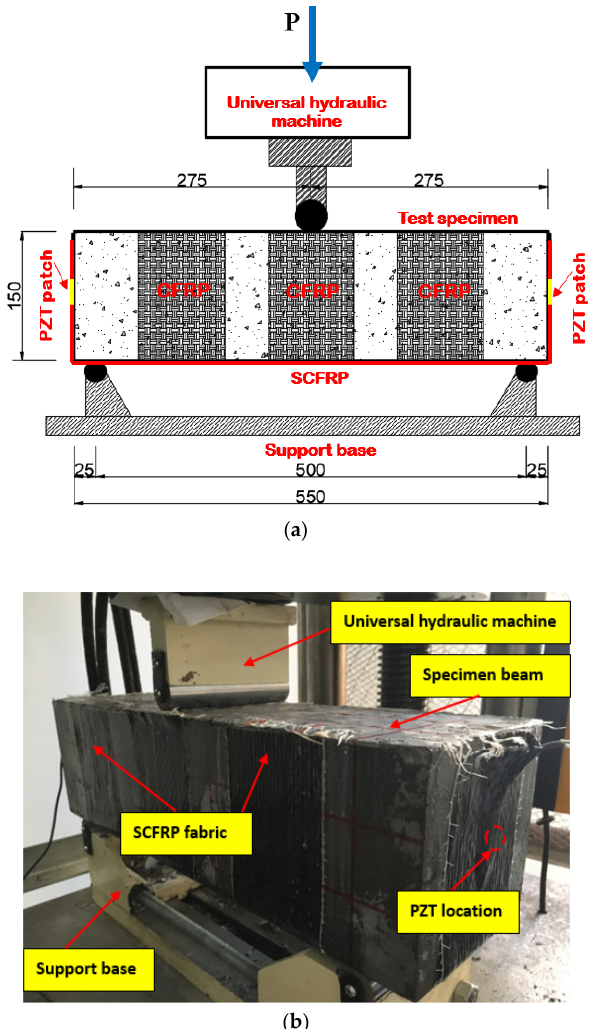
Figure 4. Experimental setup: ( a ) detail loading setup and geometric dimension (mm), ( b ) the actual test setup.